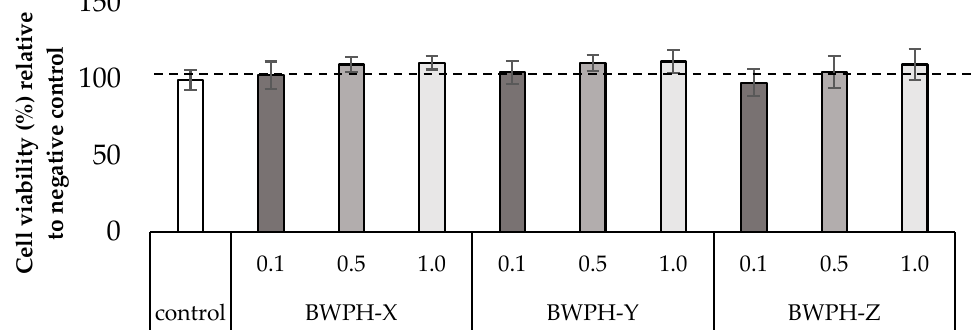
Figure 1. Viability of muscle myotube (C2C12) cells treated with 0.1, 0.5 and 1.0 mg · mL − 1 protein equivalent blue whiting ( Micromesistius poutassou ) protein hydrolysates (BWPHs). The negative control was amino acid and serum free media without BWPHs. Treatment of cells was for 4 h after 1 h of nutrient deprivation. The results represent mean ± SD (n = 3) and are expressed relative to the negative control.